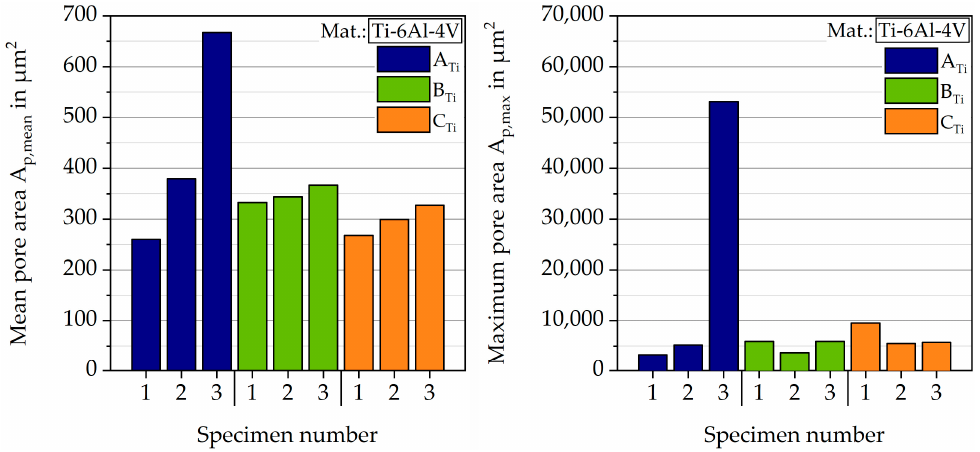
Figure 9. Mean and maximum pore area of titanium specimens.